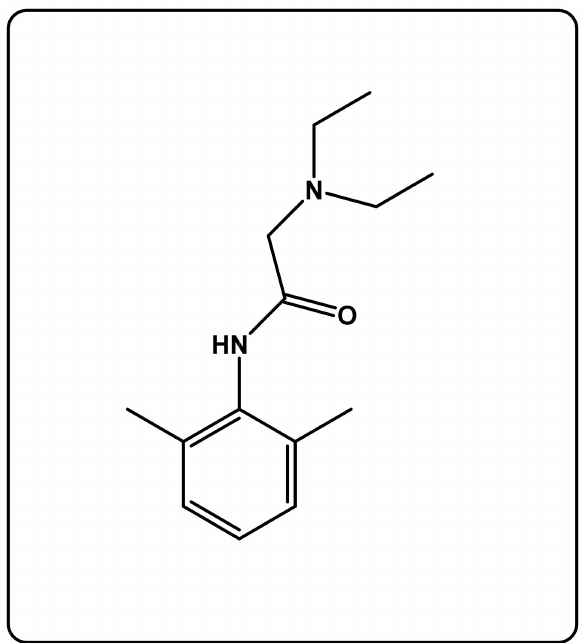
Scheme 1. Chemical structure of